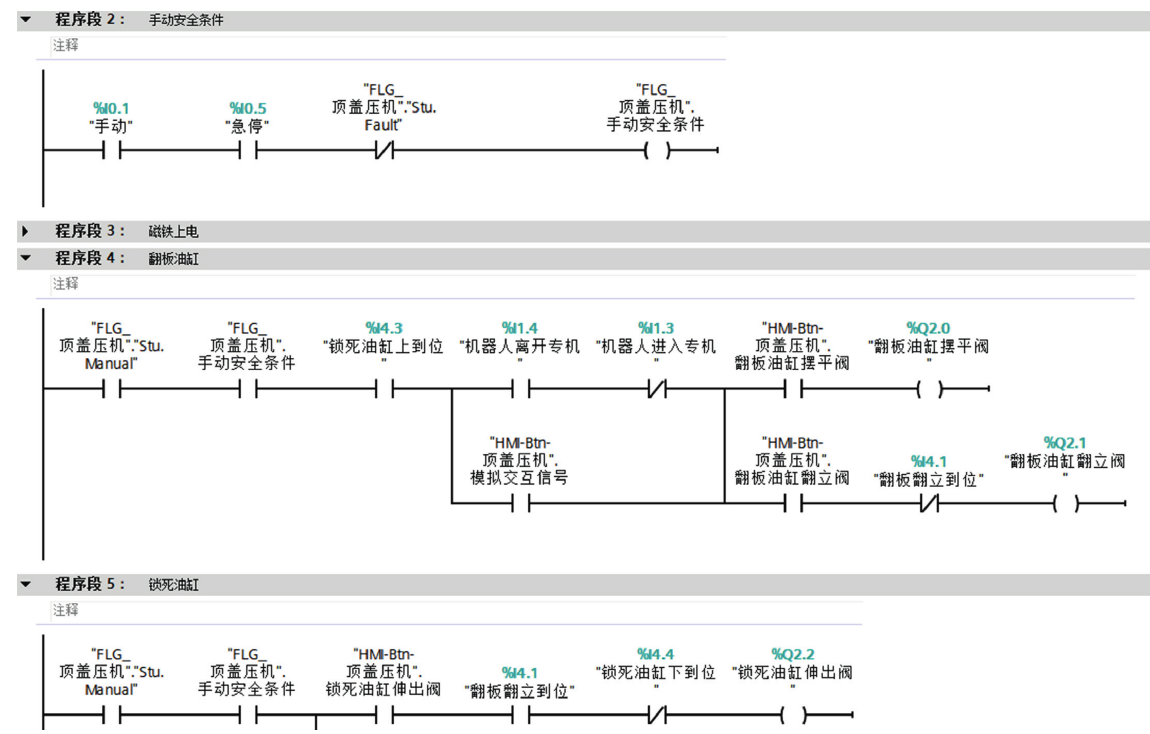
Figure 15: Part of the manual program of the water heater tank top press